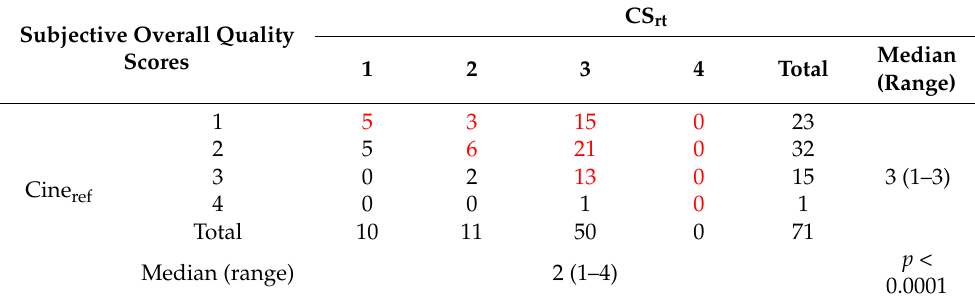
Table 6. Subjective overall image quality scores: comparison between Cine ref and CS rt image